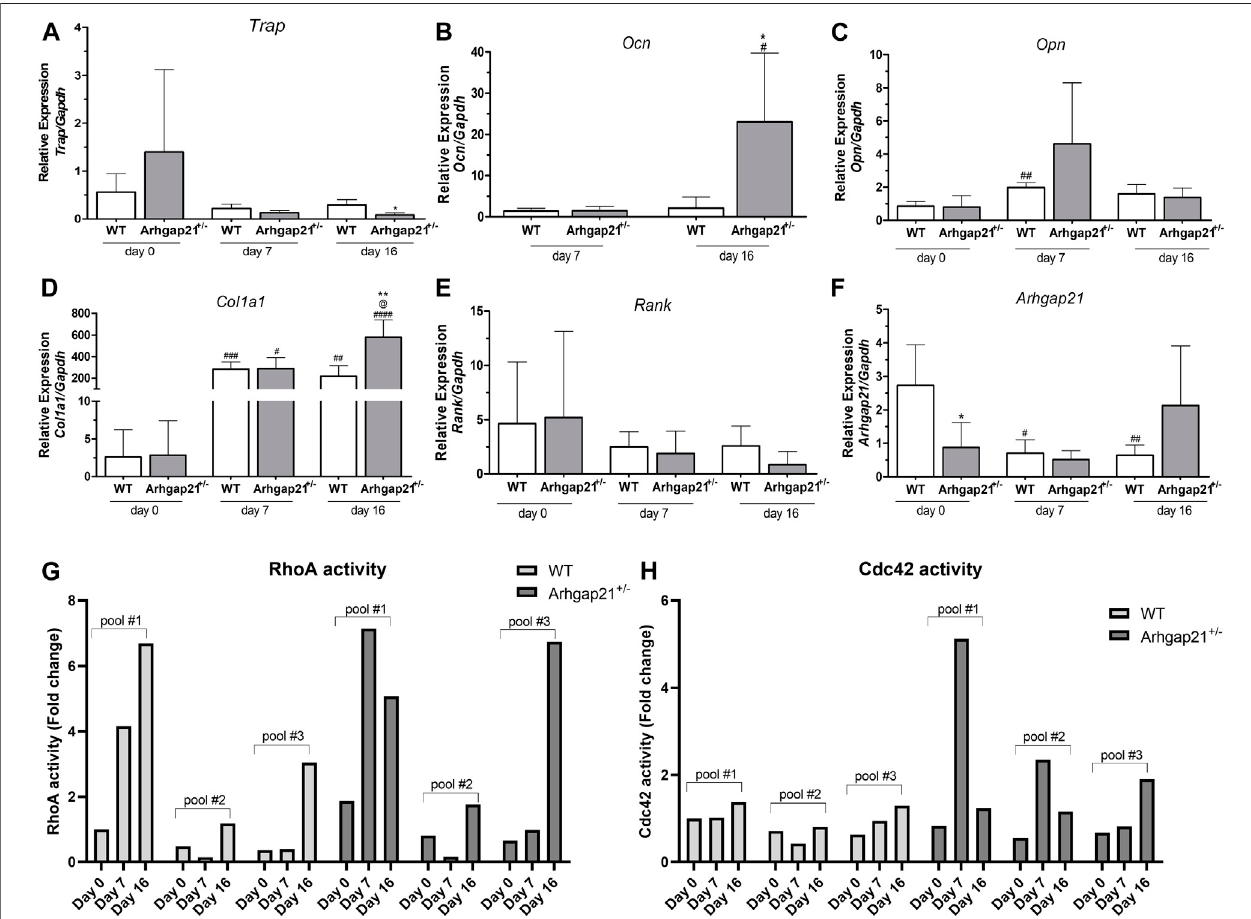
FIGURE 3 | Arhgap21 +/ − BM cells present increased expression of osteogenic markers when induced for osteoblast differentiation. (A – F) Analysis of the mRNA expression of Col1a1 , Ocn , Opn , Trap , Rank and Arhgap21 before (day 0) and on days 7 and 16 after induction of differentiation (mean ± S.D., n (cid:2) 4). (A) Expression of Col1a1 and (B) Ocn (both positive regulators of osteoblastic differentiation) was increased in Arhgap21 +/ − cells compared to WT cells on day 16 of differentiation. Ocn expression was not detected on day 0 in both groups. (D) Athgap21 +/ − cultures also showed decreased levels of Trap on day 16. Expression of (C) Opn and (E) Rank did not signi fi cantly differ between Arhgap21 +/ − and WT during the differentiation, (F) whereas Arhgap21 expression was reduced only during differentiation of WT cells. 2-wayStudent ’ s t -test. (G) RhoA and (H) Cdc42activitieswere also evaluated during osteogenic differentiation ofAhgap21 +/ − and WT BM cells. RhoA activity seems to increase through the induction of differentiation of both Ahgap21 +/ − and WT BM cells, whereas Cdc42 activity appears to increase only in Arhgap21 +/ − cells. RhoA and Cdc42 activities were analyzed in three pools of Arhgap21 +/ − or WT BM cells containing three animals each.